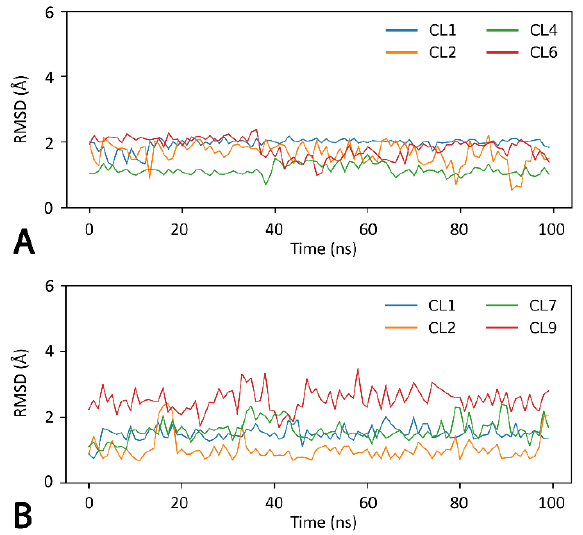
Figure 2. Analysis of the MD simulations of the different Cdk5-CPD1 ( A ) and Cdk5-CPD4 ( B )